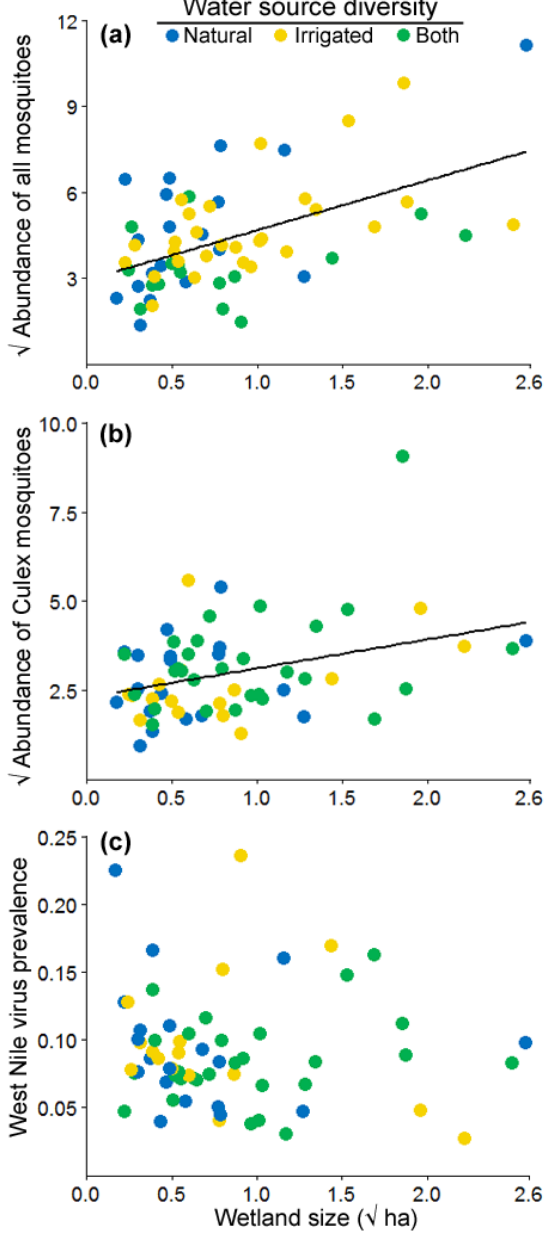
Figure A1.1. Relationships between wetland size and three elements of West Nile virus transmission risk in the Sierra Nevada foothills. (a) Mean number of all mosquitoes caught per trap/night increased with wetland size ( abundance 0.5 = 2.94 + 1.74 * size 0.5 , r 2 = 0.27, p < 0.001). (b) Mean number of Culex mosquitoes caught per trap/night increased with wetland size ( abundance 0.5 = 2.31 + 0.81 × size 0.5 , r 2 = 0.12, p = 0.005). (c) There was no relationship between mean West Nile virus prevalence in Culex and wetland size ( p =